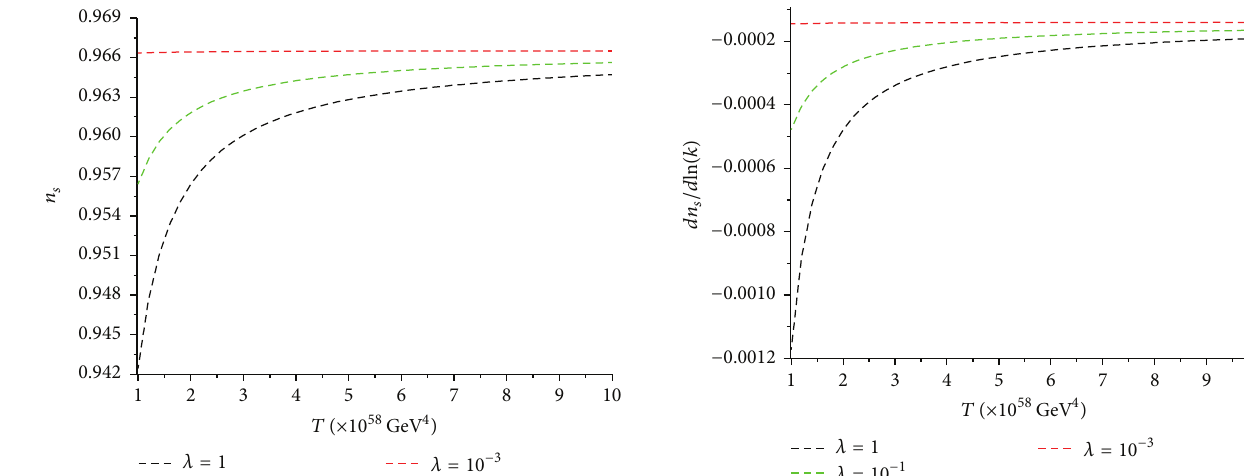
Figure 1: 𝑛 𝑠 versus 𝑇 for different values of 𝜆 for 𝜉 𝑐 = 3/16 and 𝑁 = 60 .